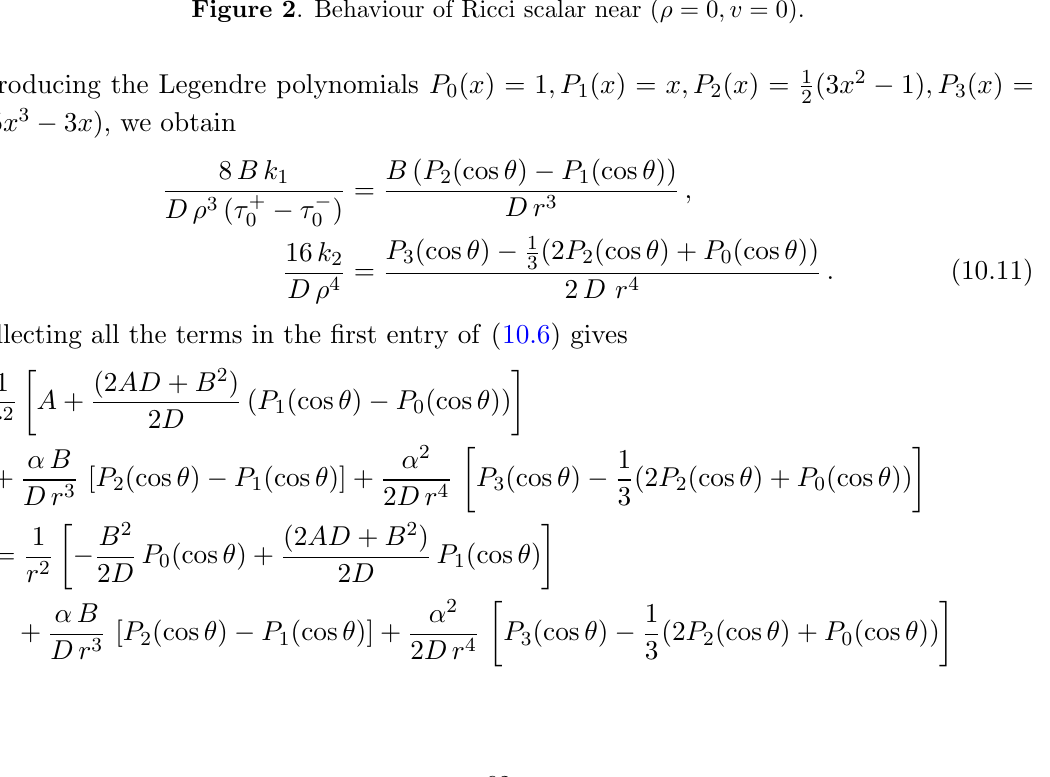
Figure 2 . Behaviour of Ricci scalar near ( (cid:26) = 0 ; v =